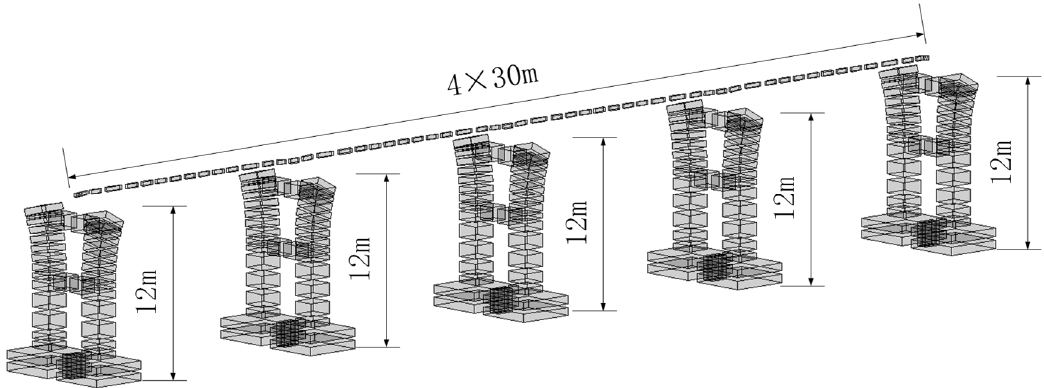
Figure 17. Finite element model.